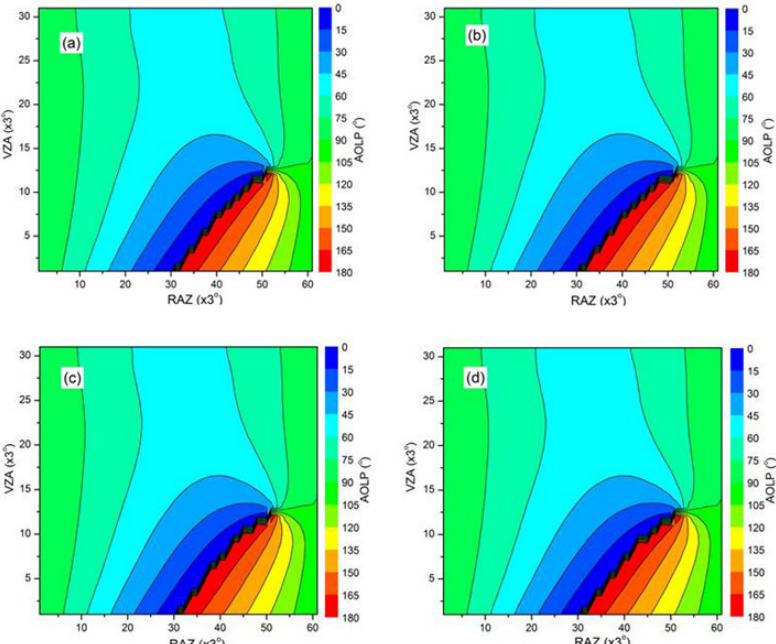
Fig. 11. Same as in Fig. 10, but for the AOLPs from the ocean wave slope probability distribution model with wind direction (a) 0 ◦ , (b) 90 ◦ , and (c) 180 ◦ , and for (d) the ocean wave slope probability distribution model without wind-direction